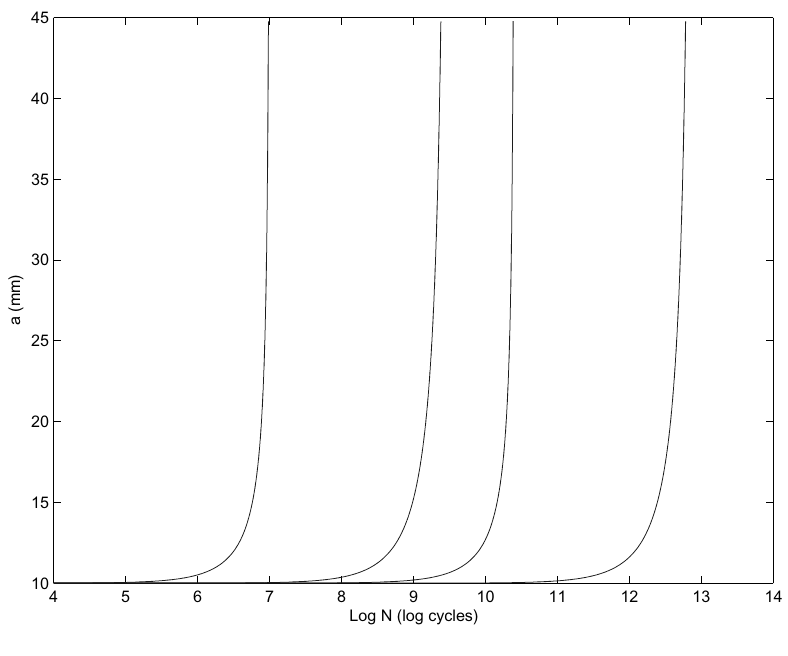
Fig. 10. Crack growth curves from vertex